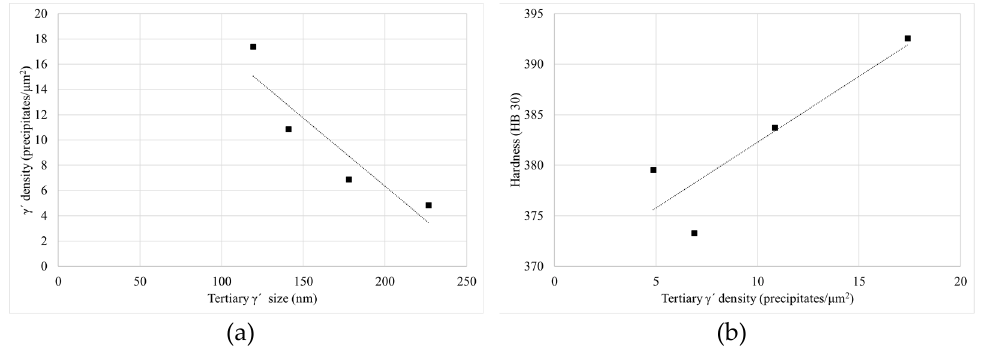
Figure 22. Relationship between ( a ) tertiary γ′ density—size and ( b ) tertiary γ′